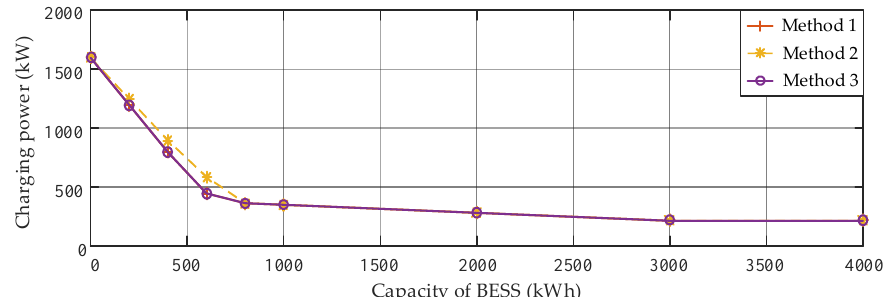
Figure 6. Performance of peak charging power reduction in three scenarios with BESS configuration.